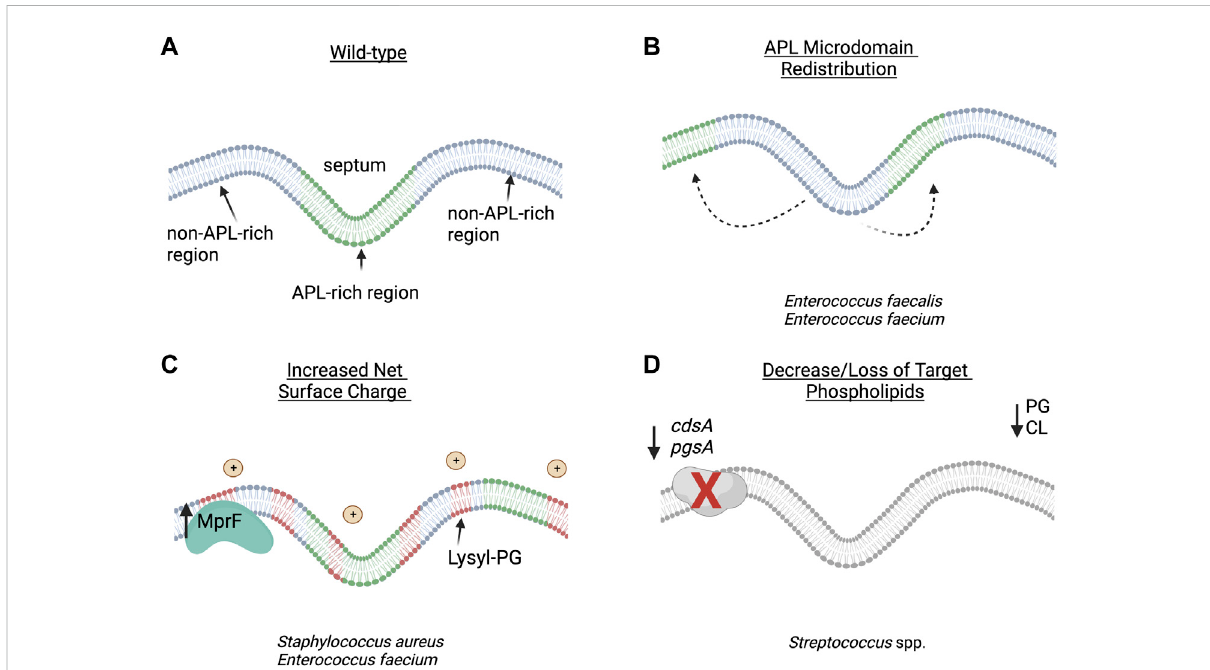
FIGURE 2 Proposed strategies of daptomycin resistance in Gram-positive pathogens: (A) wild-type bacterial cell membrane with anionic phospholipid (APL) microdomains clustered at the division septum. (B) In Enterococcus faecalis , redistribution of APL diverts daptomycin (DAP) away from the critical division septum. (C) In Staphylococcus aureus and E. faecium , changes in membrane phospholipid content and net surface charge lead to decreased daptomycin binding and oligomerization to the cell membrane. (D) In Viridans group streptococci, the decrease or loss of target phospholipid,PGandCL,areassociatedwithoverall decreasedbindingtothecellmembraneorhyperaccumulation ofdaptomycininasmallsubset of the bacterial population. APL – anionic phospholipid; CL – cardiolipin; PG – phosphatidylglycerol. Figure produced with